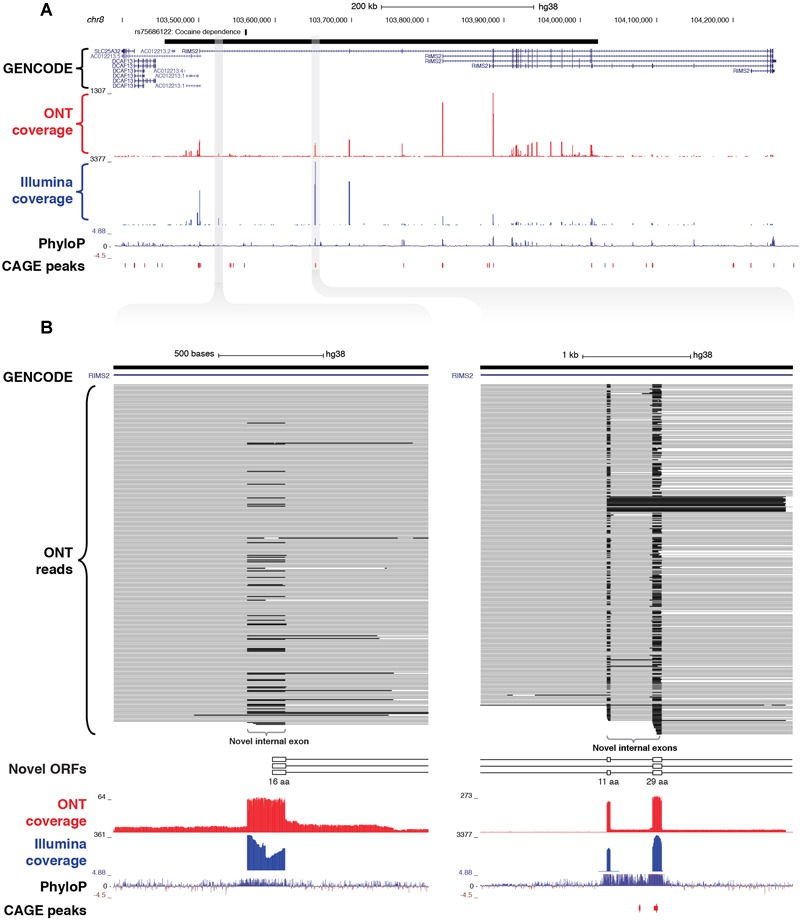
Identification of novel internal coding exons in RIMS2 gene. (A) Genome browser view shows a ∼570 kb GWAS haplotype block (solid black bar, top) on chromosome 8 associated with cocaine dependence (rs75688122). CaptureSeq detected multiple novel splice isoforms of RIMS2, a gene involved in neurotransmitter release. (B) Magnified views show three novel, highly conserved exons detected in the first intron of RIMS2, which are predicted to collectively add 56 amino acids to the start of the RIMS2 protein. The first novel internal exon includes a start codon (left), while the second and third exons (right) are in-frame (33 and 87 bp, respectively).